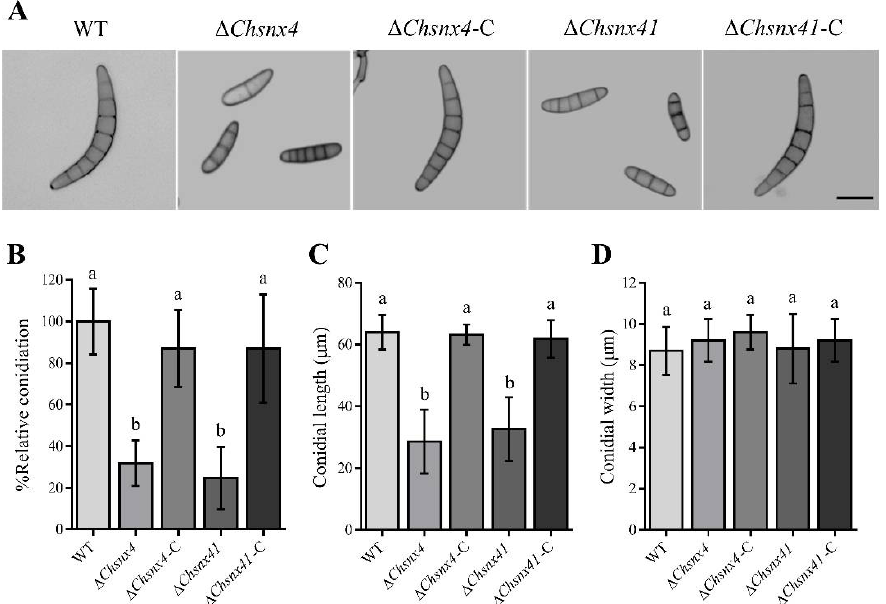
Figure 3. Snx4 and Snx41 are required for conidiation and conidia morphology in C. heterostrophus . ( A ) Representative conidial morphology of WT, mutants, and complemented strains. ( B ) Conidiation of indicated strains. X-axis: indicated strains; y-axis: relative conidiation (%). ( C ) Average conidial length of indicated strains. X-axis: indicated strains; y-axis: average conidial length (μm). ( D ) Average conidial width of indicated strains. X-axis: indicated strains; y-axis: average conidial width (μm). Each experiment had three replicates and was repeated three times. (Scale bar 10μm).